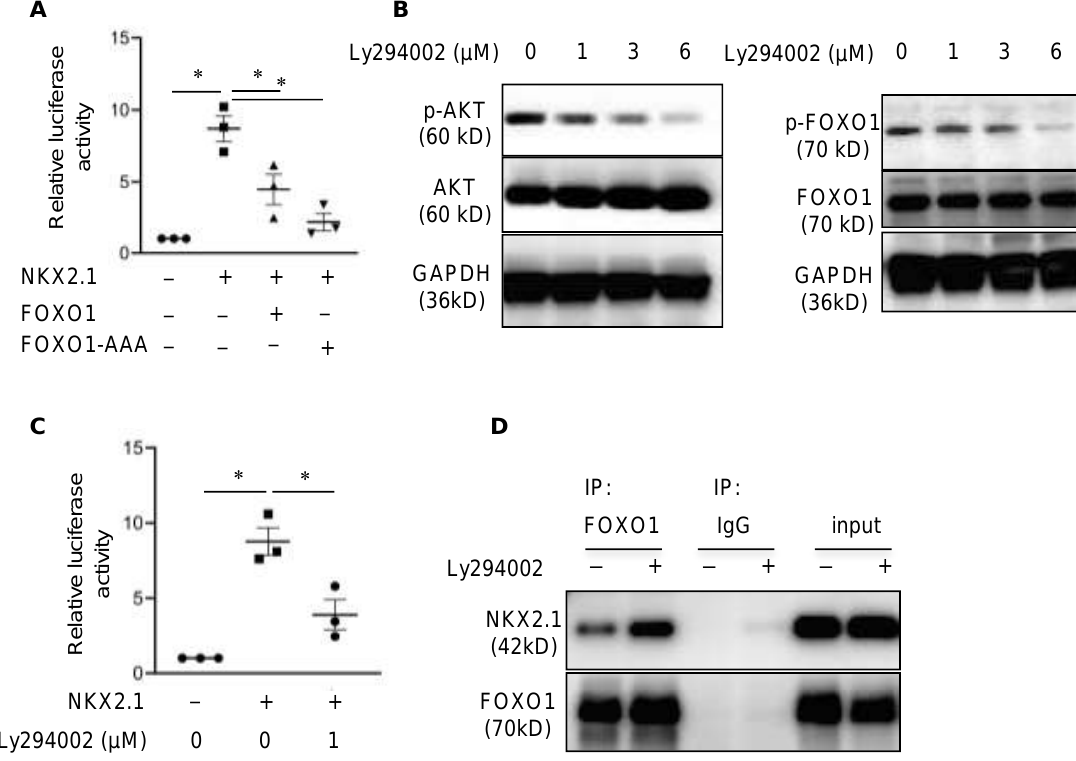
Figure 4. FOXO1 repressor function is negatively regulated by PI-3K-dependent phosphorylation. ( A ) MLE-15 cells were co-transfected with the 3.7-SFTPC-Luc reporter construct, NKX2.1 expression construct and FOXO1 or FOXO1-AAA, a dephosphorylated constitutively active form of FOXO1. Dual luciferase assays were performed 48 h after transfection. Firefly luciferase activity was normalized to Renilla luciferase. The data are shown as normalized to the absence of FOXO1 and NKX2.1. n = 3 for each group. One-way ANOVA, asterisk indicates p < 0.05. ( B ) Western blotting for p -AKT (ser473) and p-FOXO1 in MLE-15 cells shows that Ly294002 treatment (7 h) decreases p-AKT and p-FOXO1. n = 2. ( C ) MLE-15 cells were co-transfected with a 3.7-SFTPC-Luc reporter construct and NKX2.1 expression construct for 24 h, followed by treatment with Ly294002 (1 µM) for an additional 24 h. Dual luciferase assay showed that Ly294002 inhibited SFTPC reporter activity. The data are shown as normalized to the absence of both NKX2 and Ly294002. n = 3 for each group. One-way ANOVA, asterisk indicates p < 0.05. ( D ) Co-IP was performed with cell lysates that were harvested from MLE-15 cells that were cultured in the presence or absence of PI-3K inhibitor Ly294002 (6 μM) for 48 h. Increased association of NKX2.1 with FOXO1 was detected in the Ly294002-treated samples. n = 3.